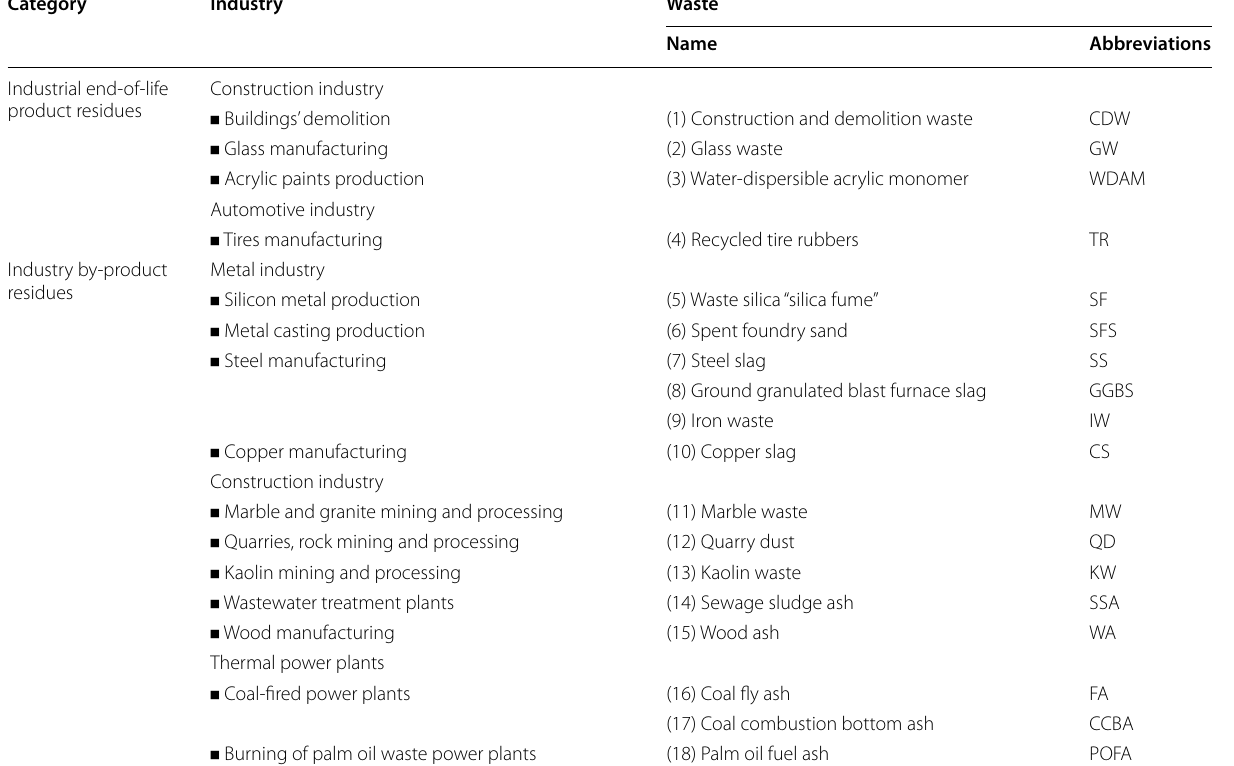
Table 1 Industrial wastes for